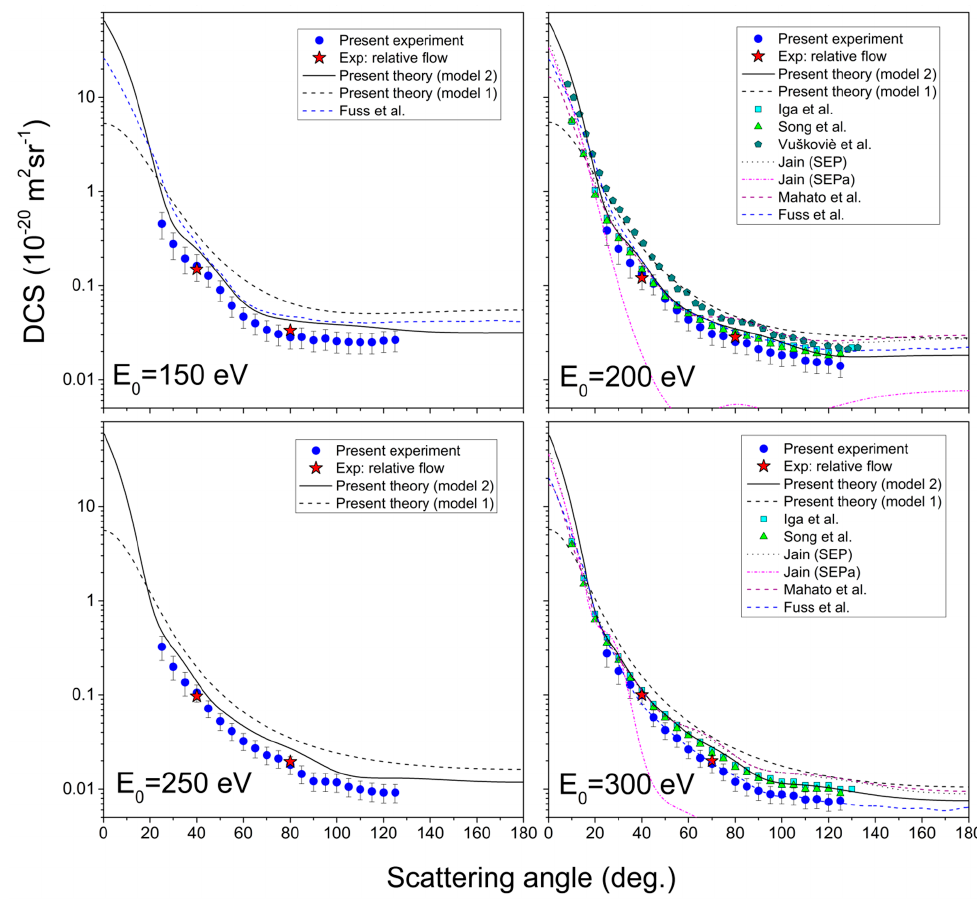
Figure 1. Angle differential cross-sections for elastic electron scattering from methane molecule, for six incident electron energies, from 50 eV to 300 eV. The present results include experiment (blue circles), relative flow absolute data (red stars), theory with molecular effects (full line) and simple sum theory (dashed line). Previous results, tabulated in Table 1, are also shown for the sake of comparison.